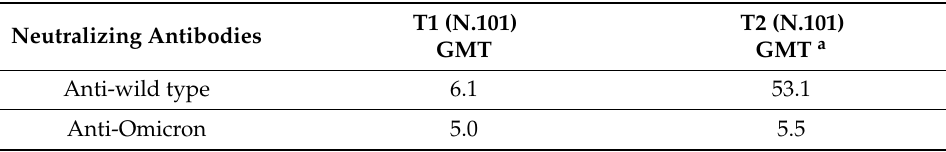
Table 3. Neutralizing antibodies geometric mean titers against the wild-type strain and the Omicron variant, 21 days after the first (T1) and 21 days after the second mRNA vaccine dose (T2), in a sub-group of healthy